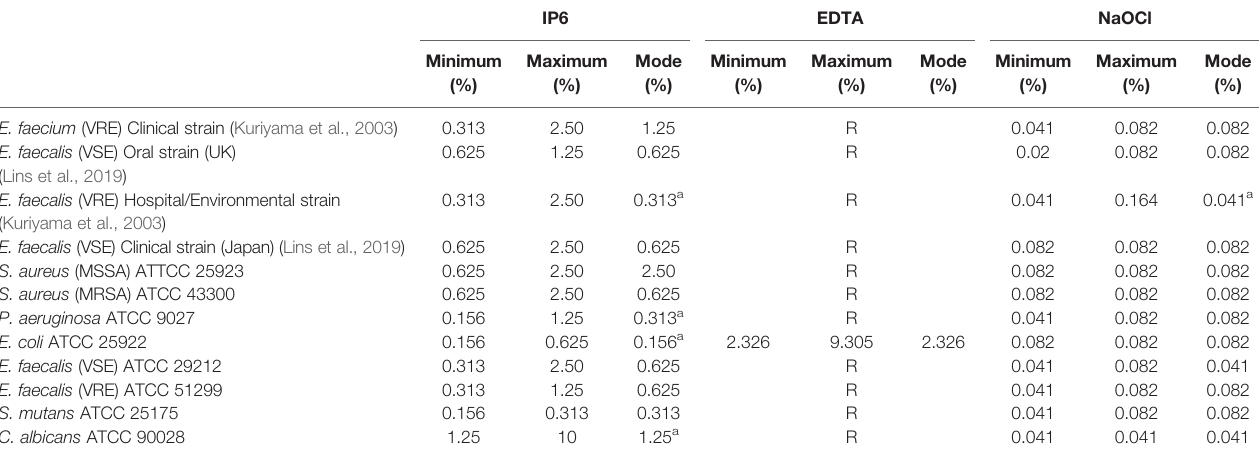
TABLE 4 | Minimum bio fi lm eradication concentration (MBEC) of IP6, EDTA or NaOCl against test